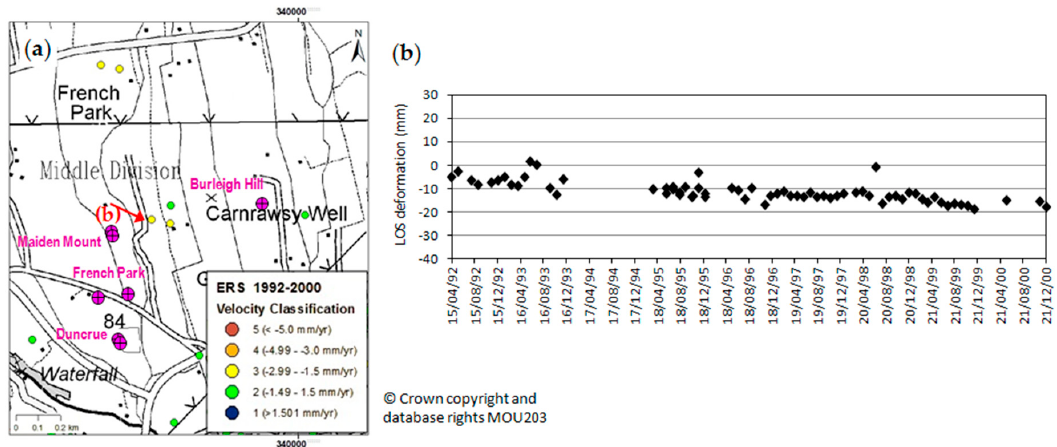
Figure 10. ( a ) Observed ground deformation and ( b ) time series for 1992–2000 in the area of the French Park and Maiden Mount salt mines in Carrickfergus. Mine shafts are indicated and labelled in pink. Reproduced from Land and Property Services data with the permission of the Controller of Her Majesty’s Stationery Office, © Crown copyright and database rights MOU203.